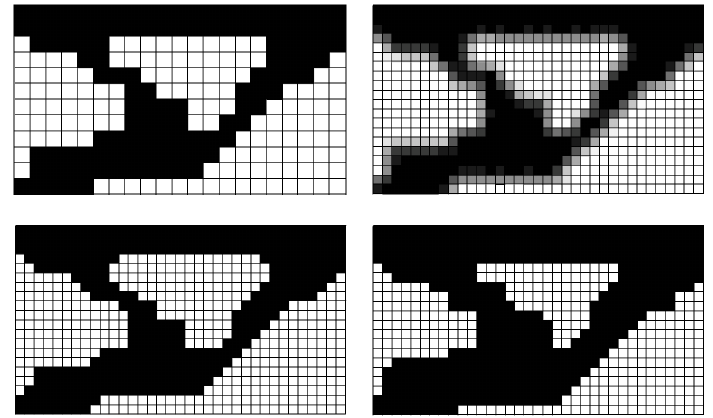
Figure 5. Ground element filtering. Top left : Initial binary distribution on a coarse mesh. Top right : Corresponding real-valued density distribution on a fine mesh. Bottom: Binary distributions on the fine mesh for ε = 0.4 ( left ) and 0.15 ( right